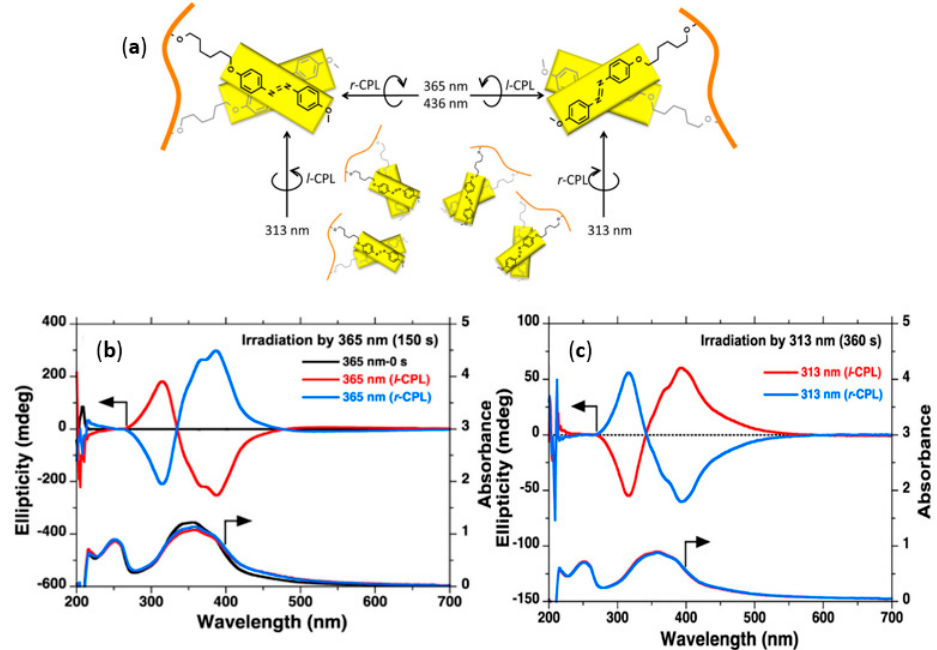
Figure 13. Proposed scheme of twisted stack led by wavelength-dependent ( a ) l- and r-CPL sources. CD and UV-vis spectra of Azo-polymer 20 aggregates exposed to ( b ) 365 nm and ( c ) 313 nm l-CPL and r-CPL. (Reprinted with permission from [231]; Copyright (2017) American Chemical Society).